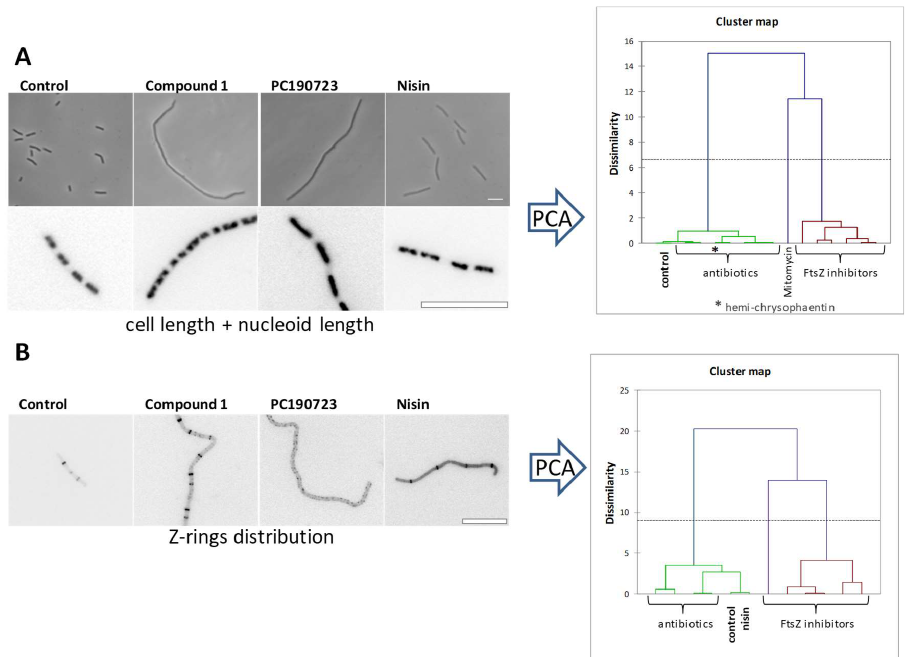
Figure 4. Cytological profile of antibacterial FtsZ inhibitors. Representative examples of B. subtilis cells observed upon treatment with 1 (3.5 μM), PC190723 (5.6 μM) and nisin (10 mg/L). ( A ) Undivided individual cells of B. subtilis 168 cells (phase contrast) and nucleoid morphology (DAPI). ( B ) Effects of FtsZ inhibitors and nisin on FtsZ subcellular localization on B. subtilis SU570 (FtsZ-GFP, contrast inverted). Scale bars: 10 μm. Right graphs, dendrograms obtained after a hierarchical cluster analysis based on values from a principal component analysis (PCA) using unweighted variables cell length and nucleoid length (upper graph) or Z-rings distribution (lower graph) [65].